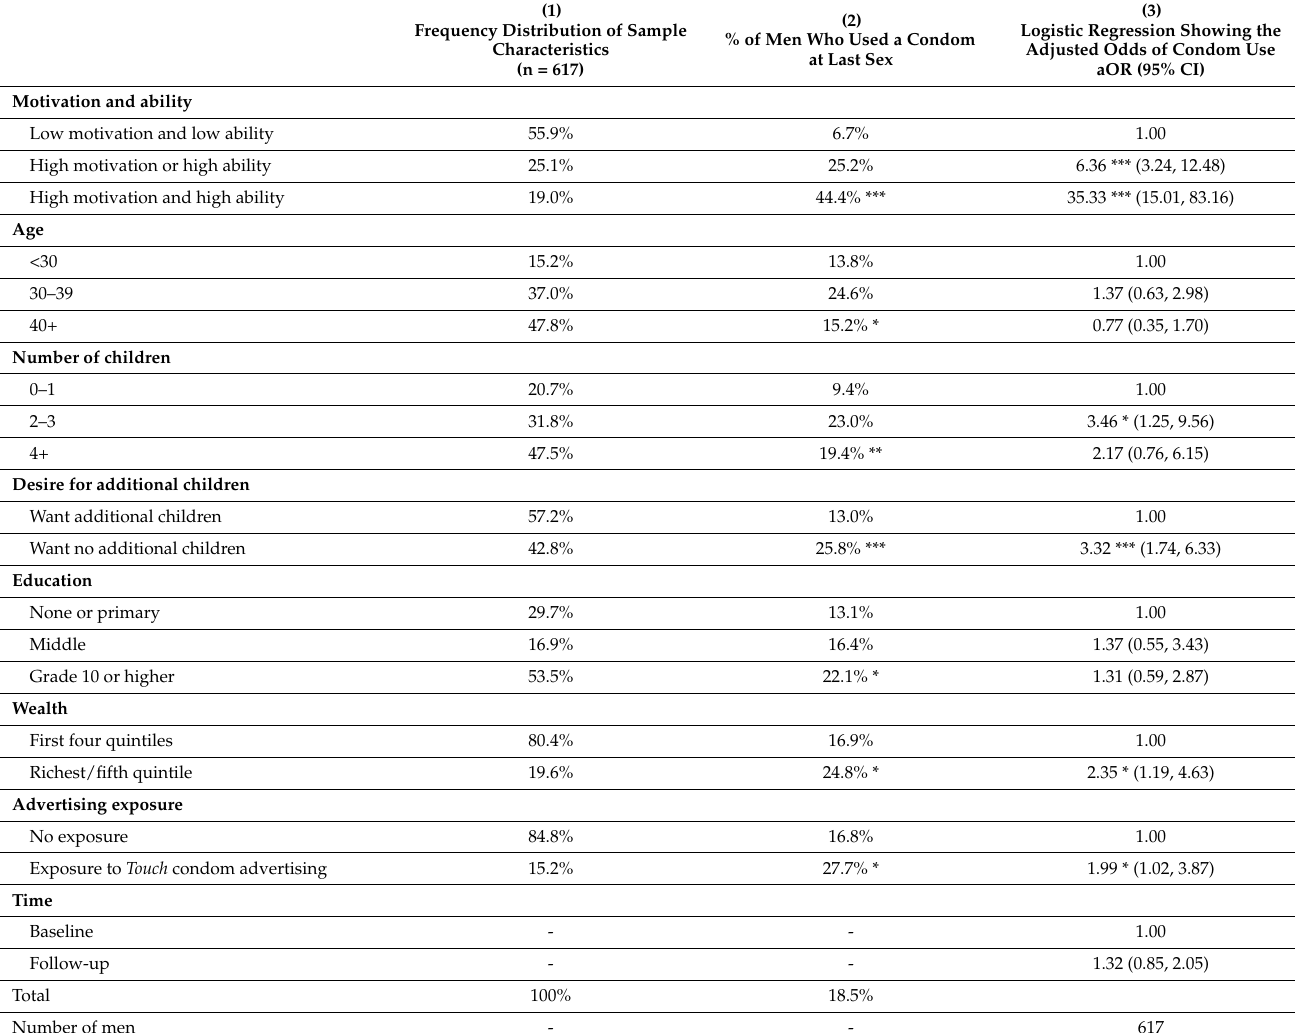
Table 4. Frequency distributions, cross tabulations and adjusted odds of condom use among men,